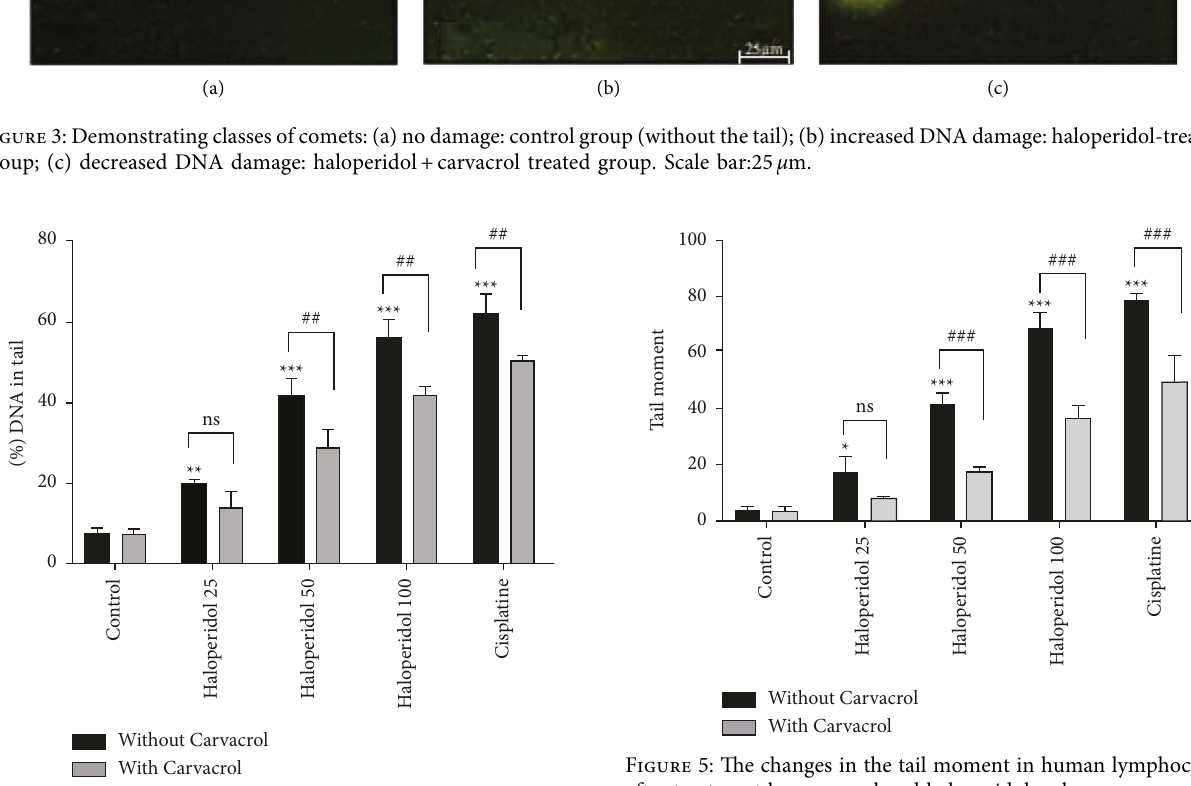
Figure 4: The percentage of DNA in the tail in human lymphocytes after treatment by carvacrol and haloperidol; values are presented as the mean ± SD; ∗∗ significantly different compared to the control group without carvacrol ( P < 0 . 01); ∗∗∗ significantly different compared to the control group without carvacrol ( P < 0 . 001); ##significantly different in comparison with the haloperidol- treated group without carvacrol ( P < 0 . 01); ns: not significant.